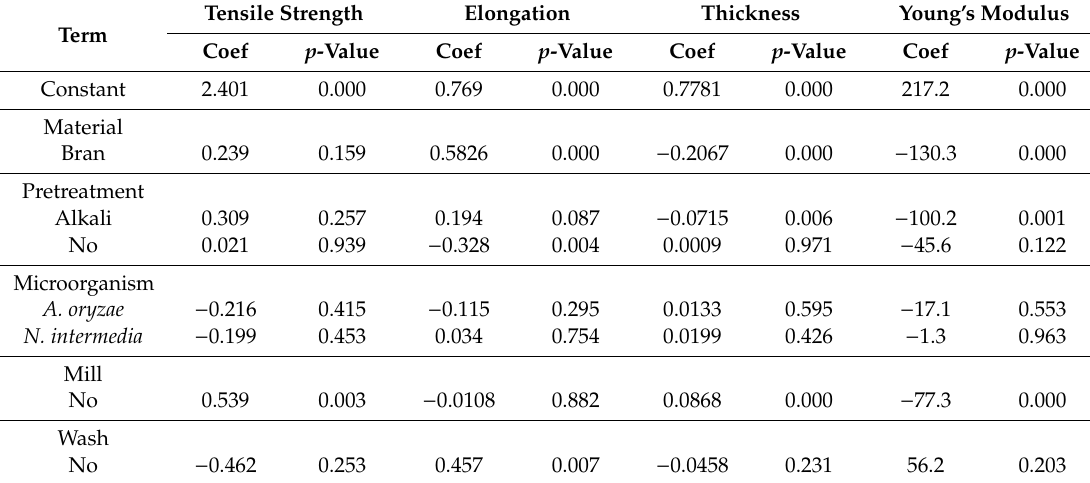
Table 2. Coe ffi cients of the general linear